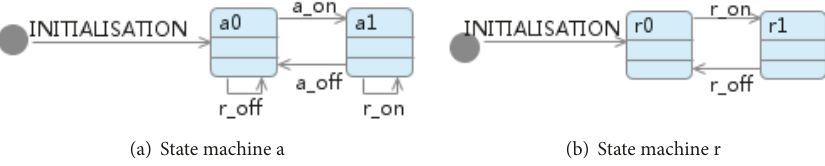
Figure 8: The principle of modelling.